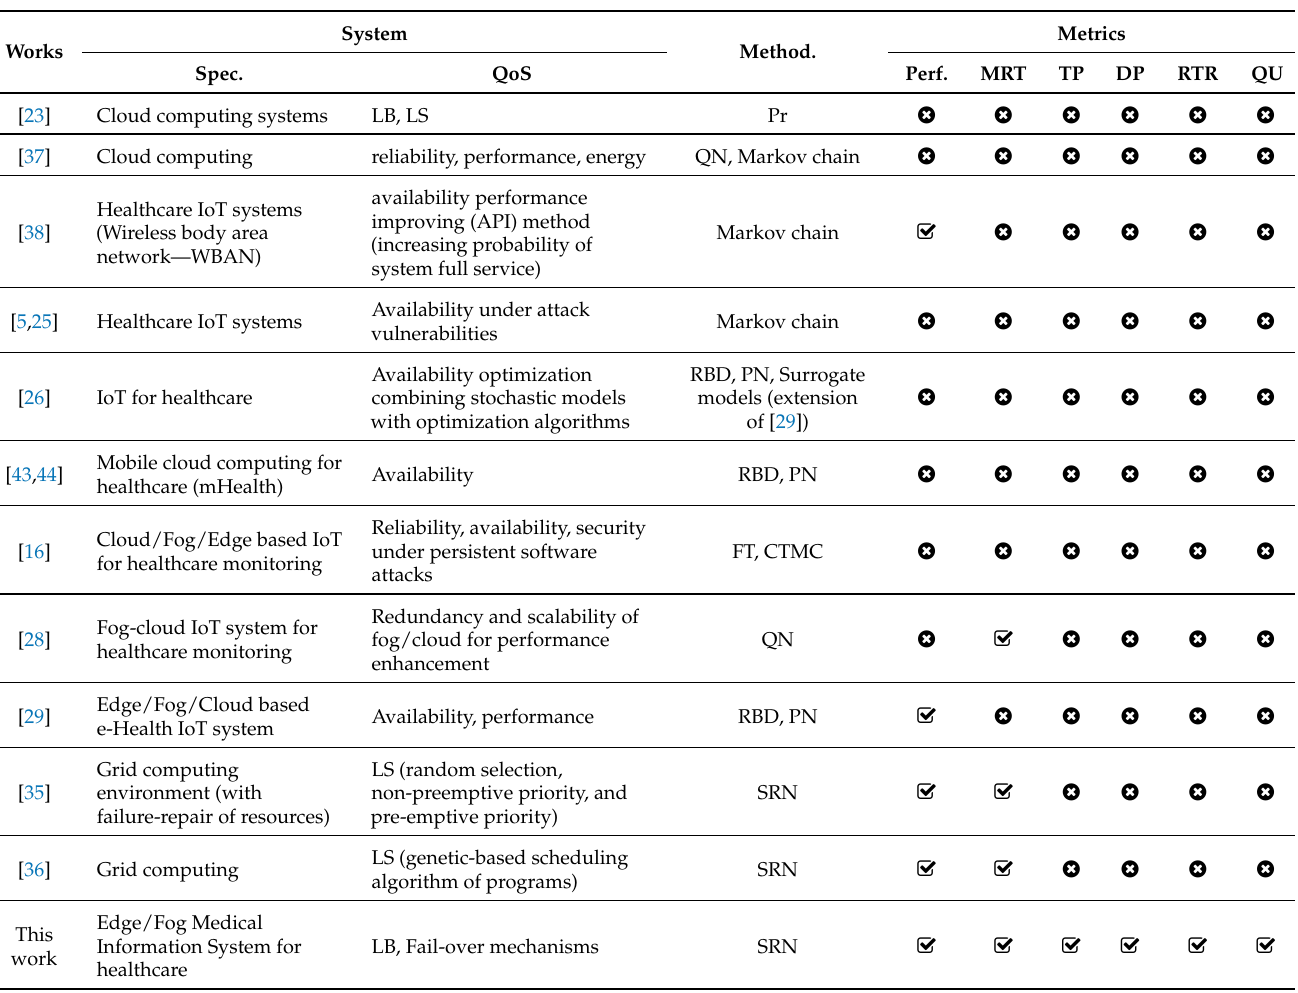
Table 1. Selected Works in